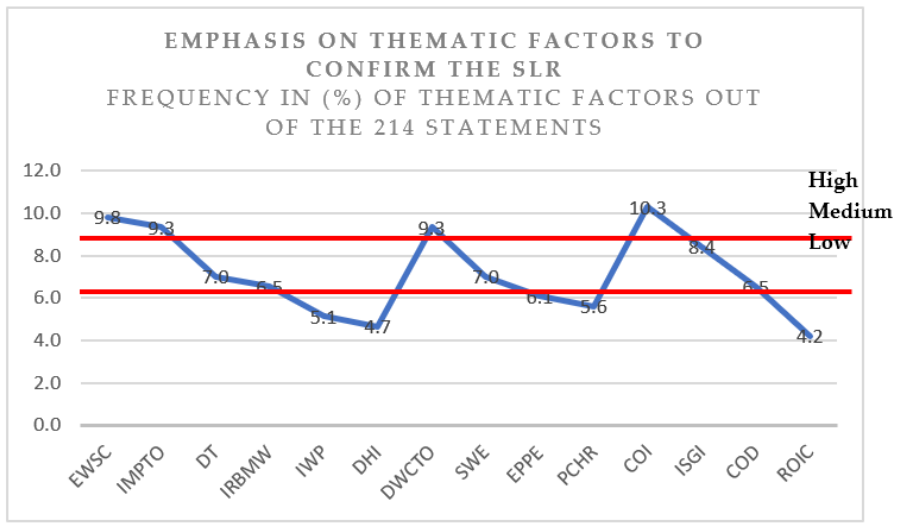
Figure 8. Cross-case analysis (source: own study). Table 6. Scale of importance (source: own study).